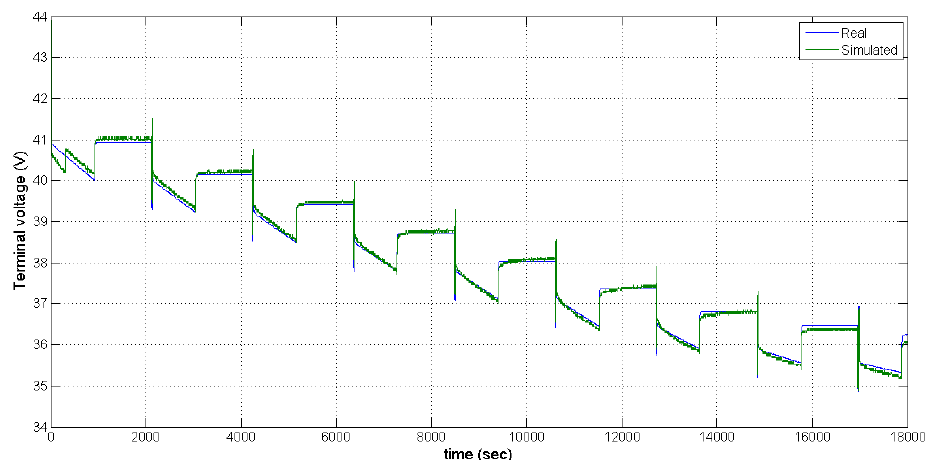
Figure 14. The comparison between actual response of the battery and the simulation under the hybrid pulse power characterization (HPPC) test.